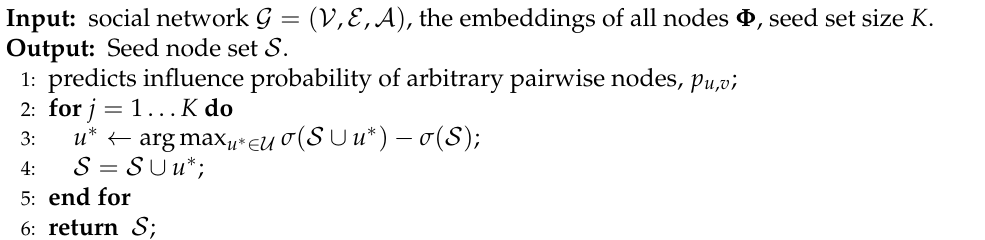
Algorithm 1 HGE-GA